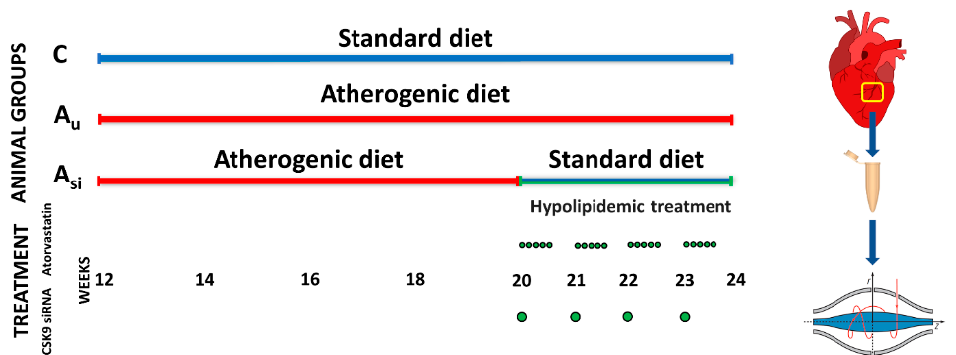
Figure 1. Animal experimental workflow presenting the three groups of New Zealand White rabbits under a standard diet for three months (Control group: C), under a hyperlipidemic diet (standard diet supplemented with 0.5% cholesterol and 5% corn oil) for the same amount of time (atherosclerotic group: Au), and a group of rabbits which, after two months of hyperlipidemic diet, were switched to a standard diet for the last month together with the administration of a daily oral dose of atorvastatin and a weekly IV dose of PCSK9 siRNA (Asi). The animals’ euthanasia was performed after three months of experimentation followed by blood and organ harvesting. Inter-ventricular myocardial tissue, containing part of the left-descending coronary artery, was mechanically homogenized and used for downstream assays, including high-resolution orbitrap-based mass spectrometric proteomic analysis.